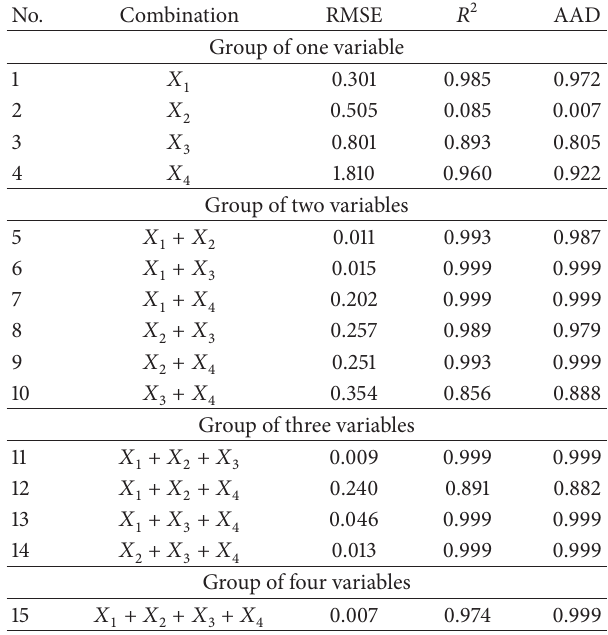
Table 2: Values of connection weights (parameters of the model) for the completed ANN model.